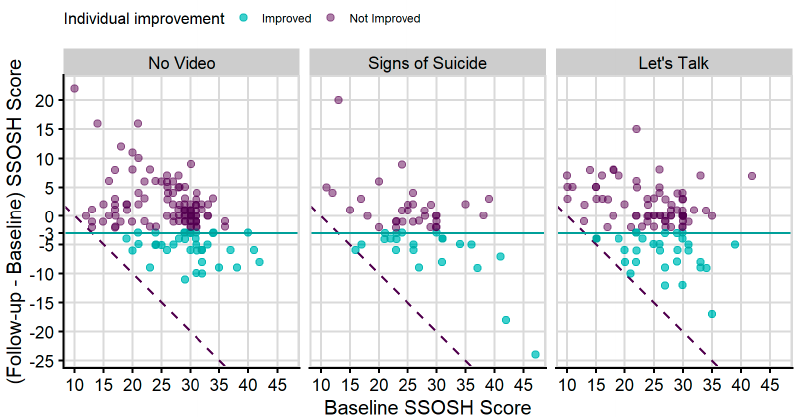
Figure 3. Plot of change in SSOSH against baseline SSOSH score for Study 2. The dashed line shows the greatest possible improvement for each baseline score. The horizontal line is the practi- cally meaningful individual improvement cutoff at − 3.